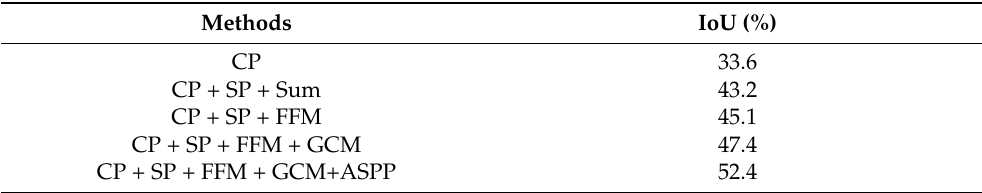
Table 3. Ablation study of components on the validation set. CP: Context Path; SP: Spatial Path; GCM: Global Context Module; FFM: Feature Fusion Module.